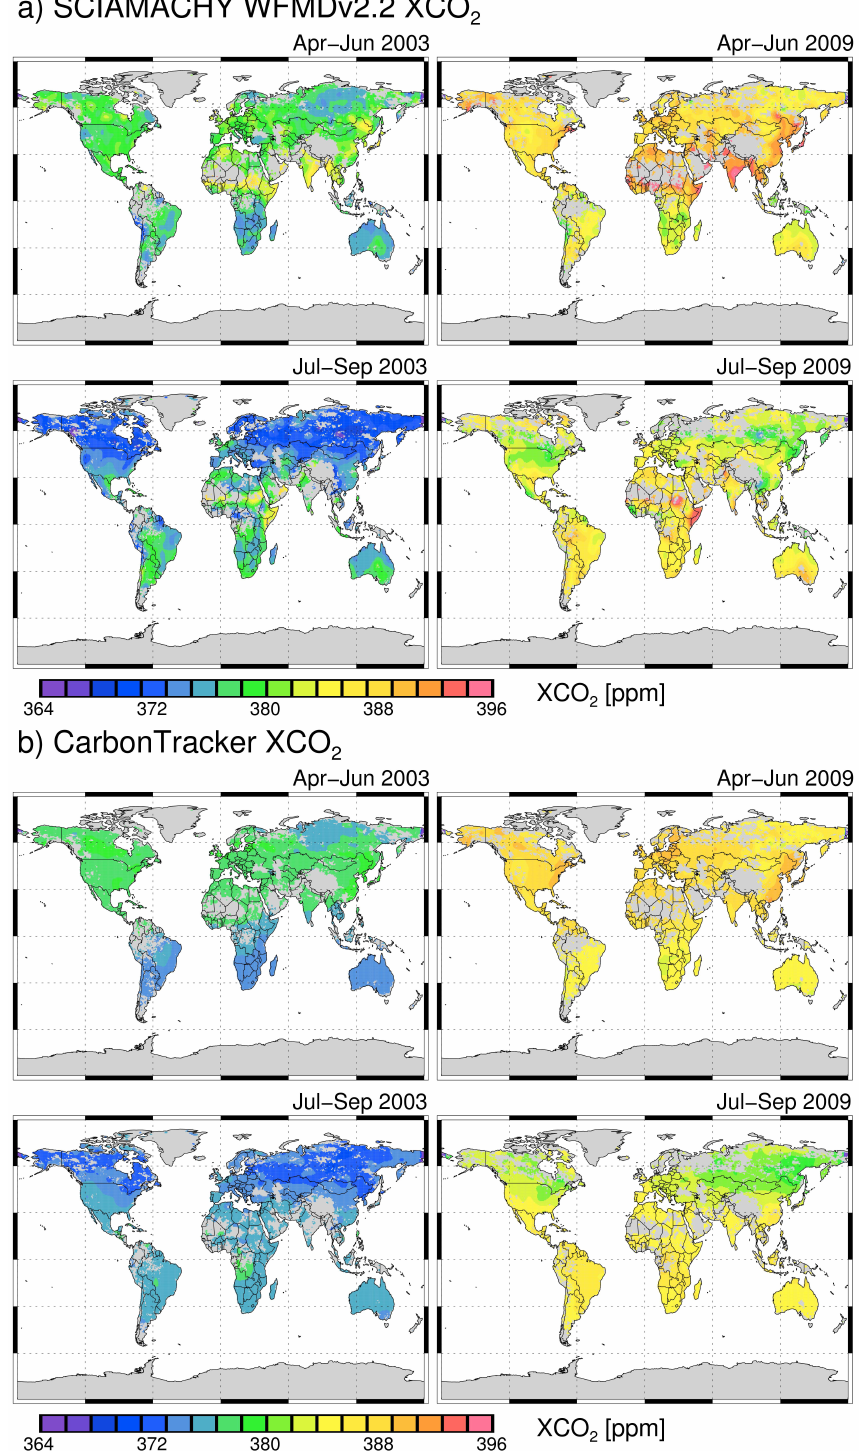
Fig. 8. Comparison between global SCIAMACHY and CarbonTracker X CO 2 . (a) Global SCIAMACHY WFMDv2.2 X CO 2 maps for the time periods April–June and July–September in 2003 and 2009. The data have been gridded on a 0.5 ◦ × 0.5 ◦ latitude/longitude grid and smoothed by using a 2-D-Hann window with a width of 20 × 20 (10 ◦ × 10 ◦ ). (b) as in (a) but for CarbonTracker X CO 2 sampled as the SCIAMACHY